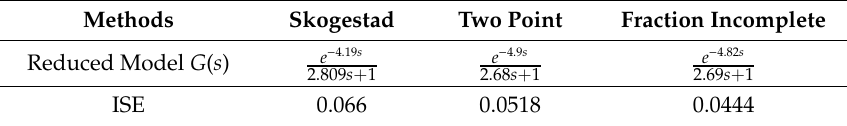
Table 3. Performance comparison of order reduction